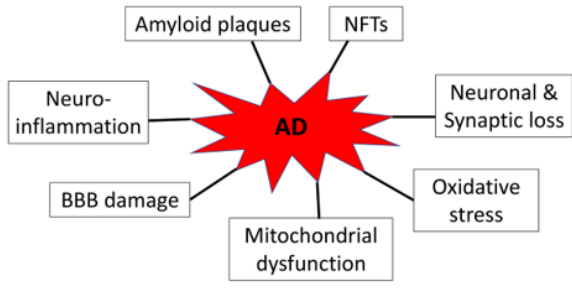
Figure 1. AD-associated